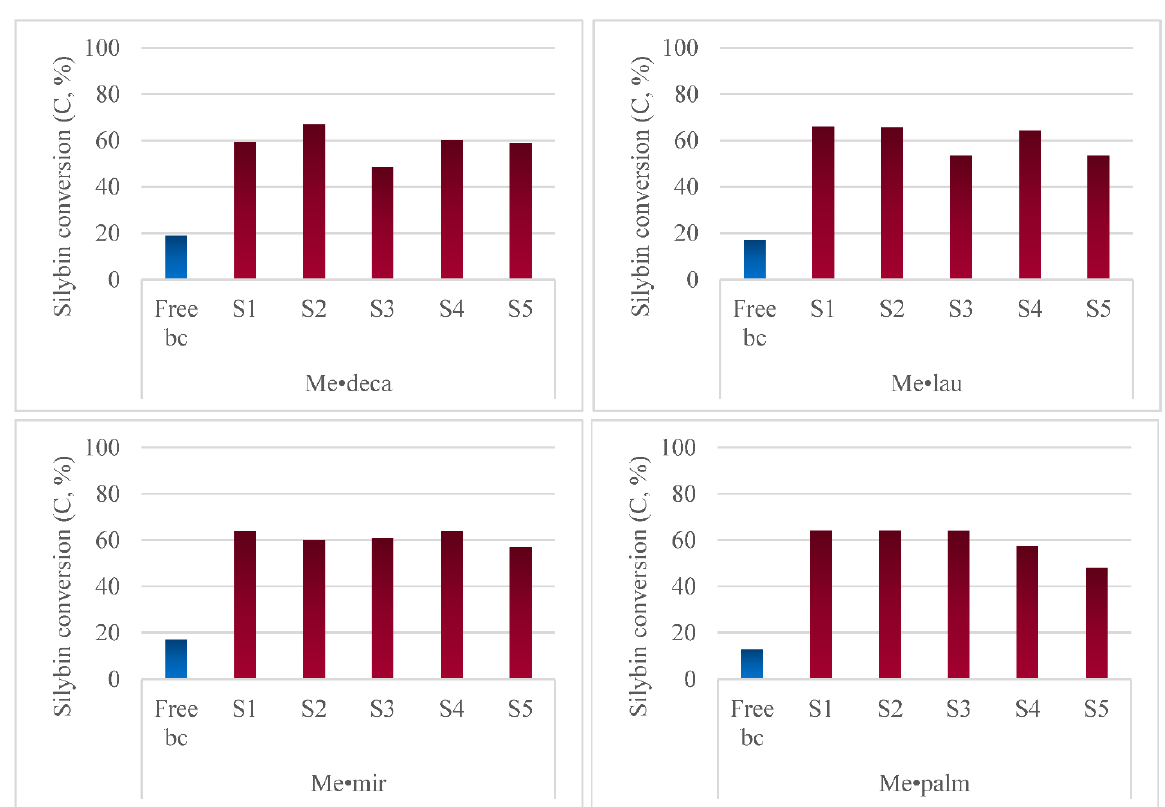
Figure 5. System performance in terms of silybin conversion for every biocatalyst specimen. Experimental conditions: 2 mM Silybin A/B, 45 mM Me-decanoate (Me●deca), 40 mM Me-laurate (Me●lau), 35 mM Me-miristate Me●mir), 30 mM Me-plamitate (Me●palm), 1:10 v/v biocatalyst, free ( ■ ) or immobilized ( ■ ), in 1 mL THF, at 25 °C and 1000 rpm for 24 h.